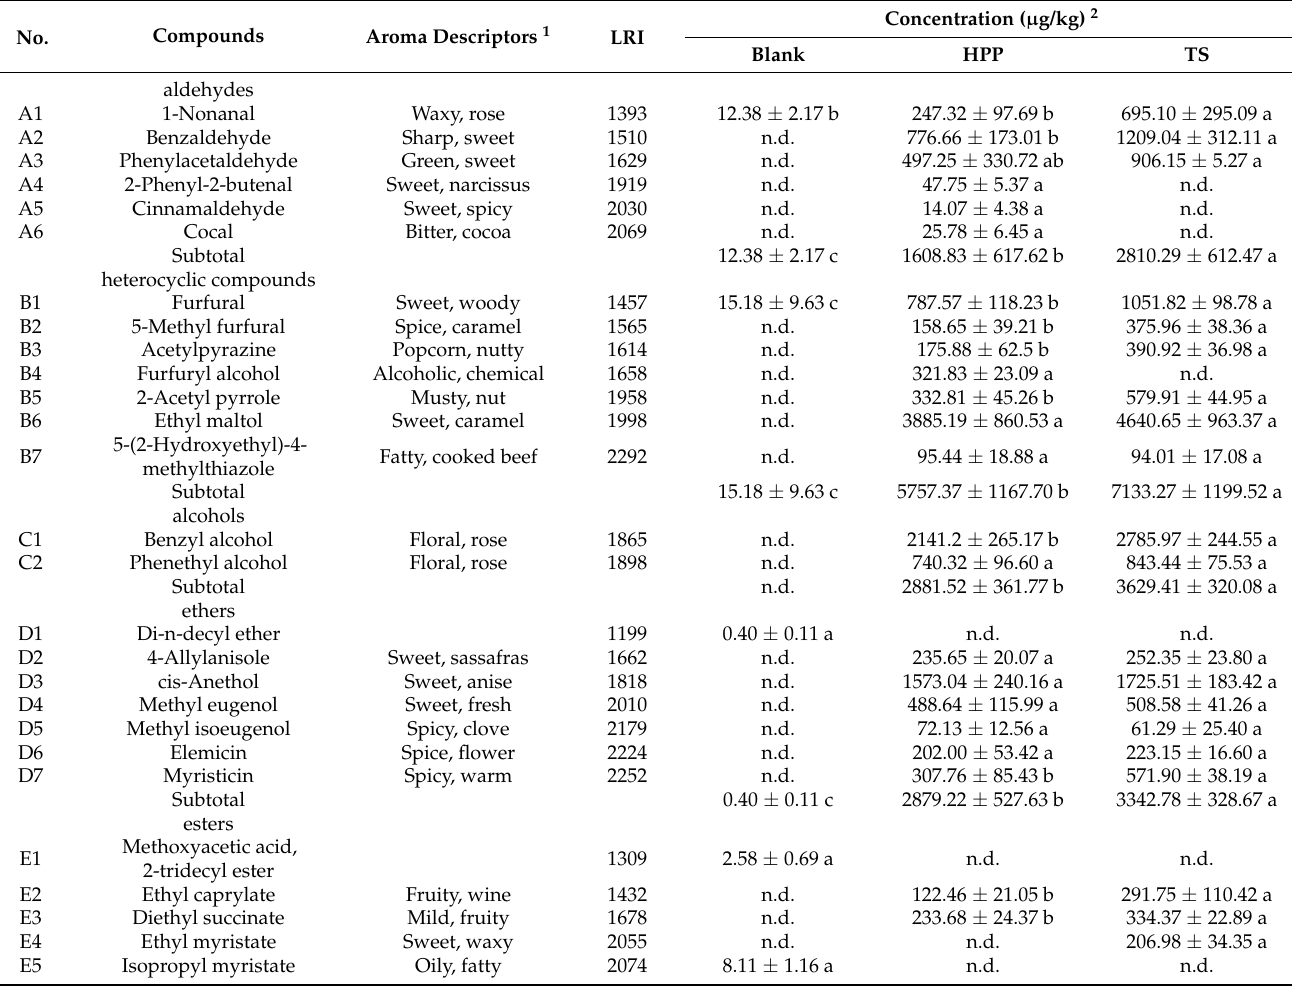
Table 1. Volatile profiles of HPP and TS marinated lotus root